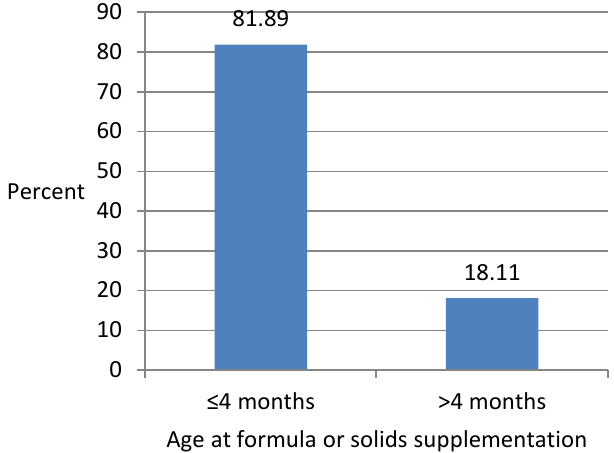
Figure 1. Distribution of age at introduction to formula or solid foods.